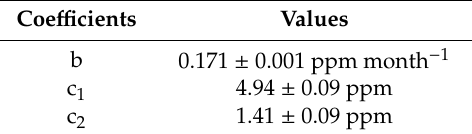
Figure 9. Spectral analysis result of the mean background CO 2 values. Table 1. Values of the coe ffi cients in Equation (2).